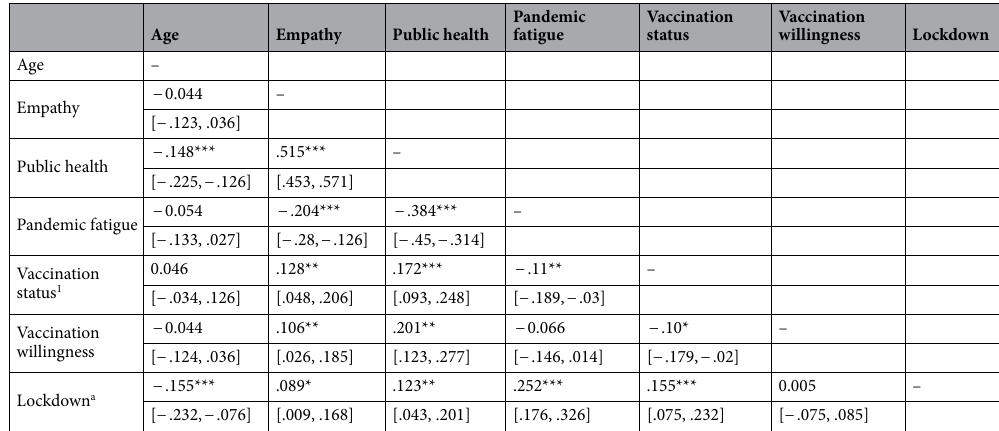
Table 1. Correlation matrix of age, empathy, support for public health measures, pandemic fatigue, vaccination status (yes/no), vaccination willingness and lockdown status (no lockdown, lockdown). Pearson’s r , with 95% confidence intervals shown in brackets. a = point biserial correlation was calculated. * p < .05, ** p < .01, *** p <